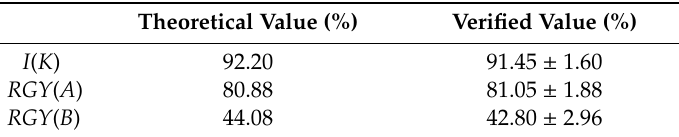
Table 3. Results of the CCD verification experiment.